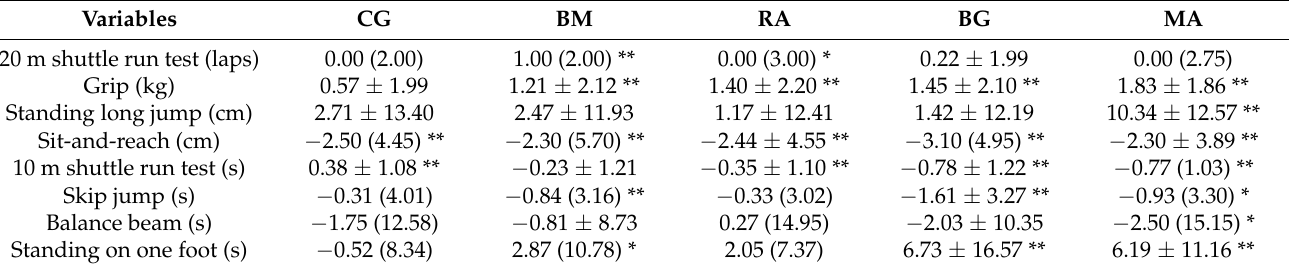
Table 2. Difference of Physical Fitness before and after